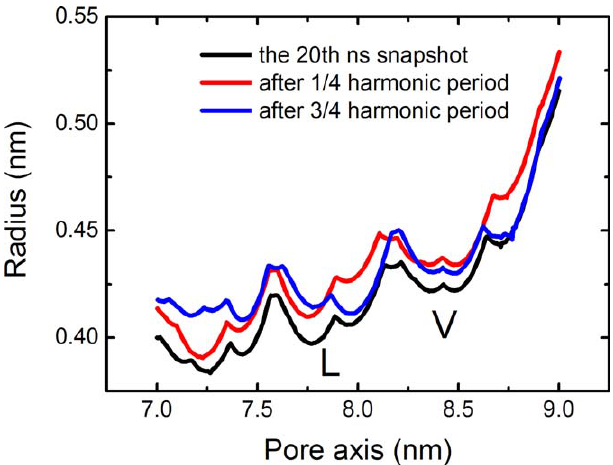
Figure 6. Pore Radius Profiles versus Position along the Pore Axis Three curves were produced on the basis of C a atoms of M2 helices from the 20th ns snapshot as well as the structures resulting from the NMA on this snapshot.